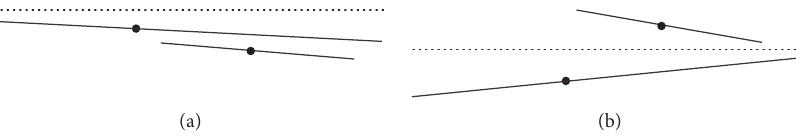
Figure 4: The first two orders of models of the dual-rotor. (a) The first order and (b) the second order.